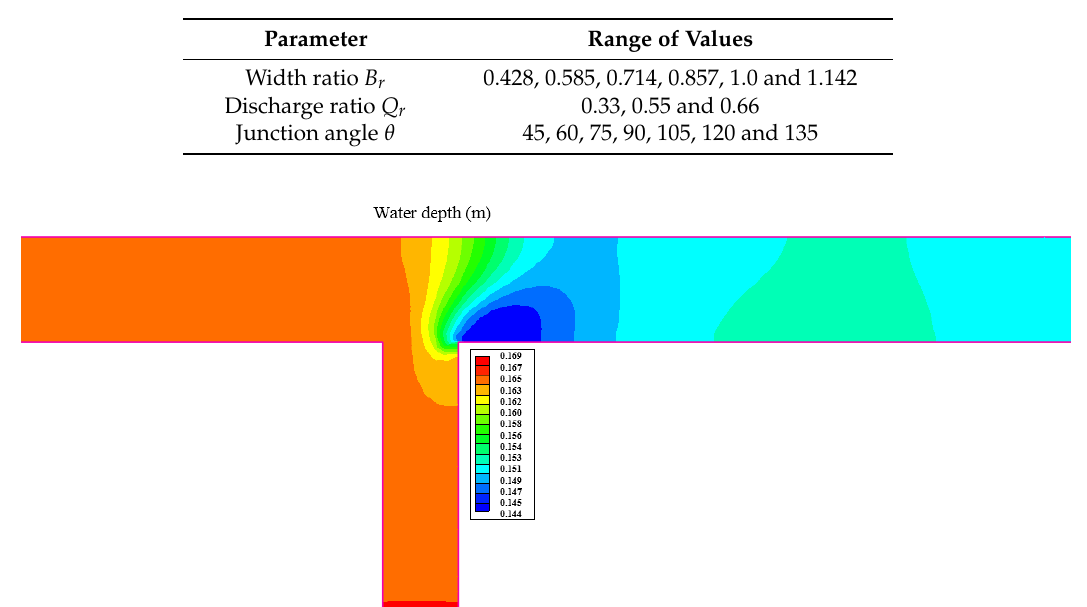
Figure 9. Variation in water depth; Run 2.